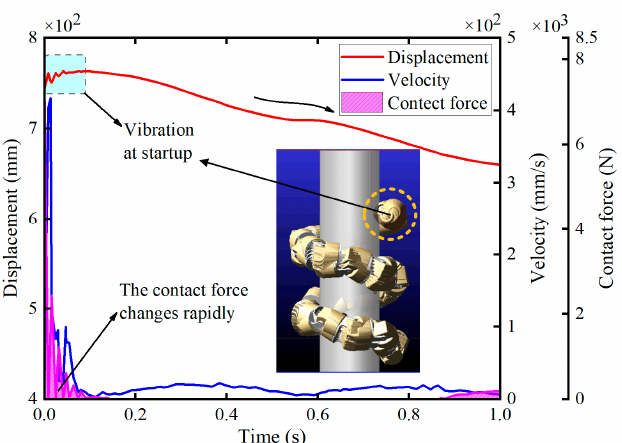
Figure 14. The vibration of the head module at